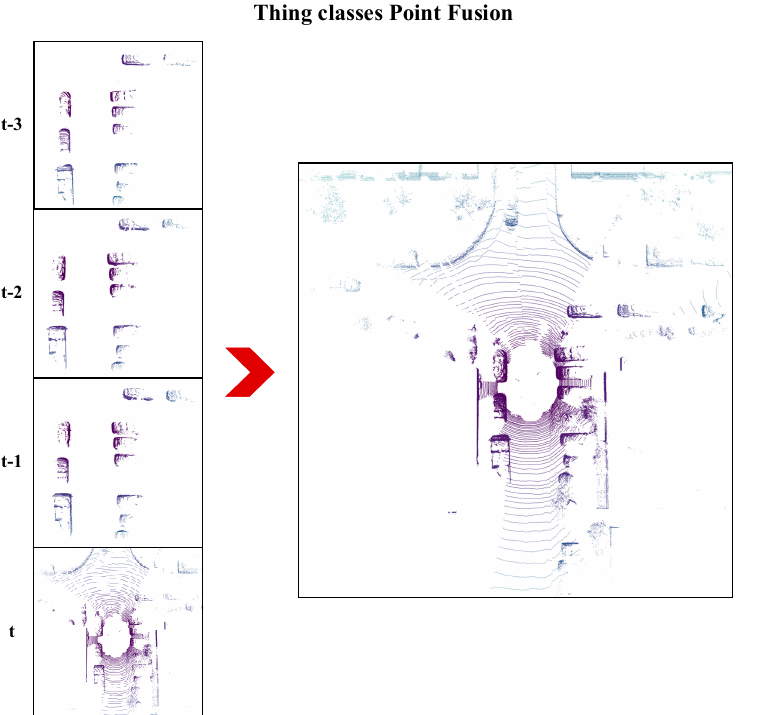
Figure 4. Schematic diagram of data fusion of environmental element point cloud in “thing classes”. The “thing classes” environmental element points in the time window were selected and fused with the current scan through coordinate transformation to obtain relatively complete instance information of “thing classes” environmental elements.